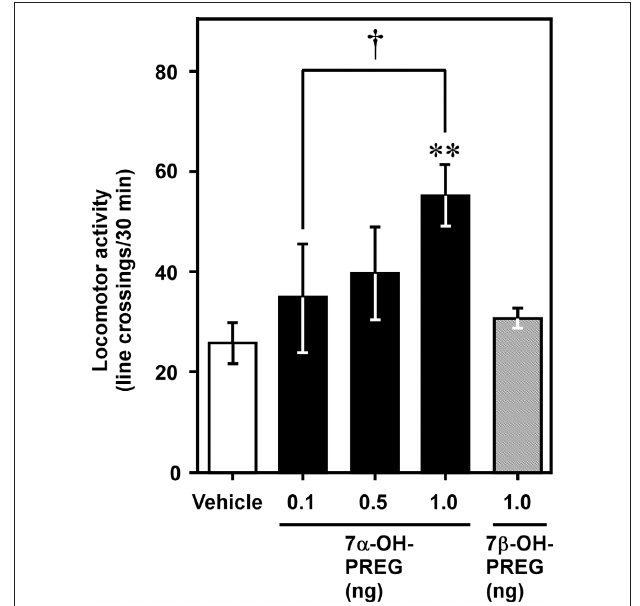
FigurE 3 | Effect of 7 α -hydroxypregnenolone on locomotor activity of male newt. Male newts in the non-breeding period received an i.c.v. injection of vehicle ( n = 7), 7 α -hydroxypregnenolone (7 α -OH PREG; 0.1 and 0.5 ng: n = 6; 1 ng: n = 7), or 7 β -hydroxypregnenolone (7 β -OH PREG; 1 ng: n = 6). Each column and vertical line represents the mean ± SEM total number of crossings. ** p < 0.01 vs. vehicle, † p < 0.05 vs. 0.1 ng of 7 α - hydroxypregnenolone injection by one-way ANOVA, followed by Duncan’s multiple range test. Adapted from Matsunaga et al.